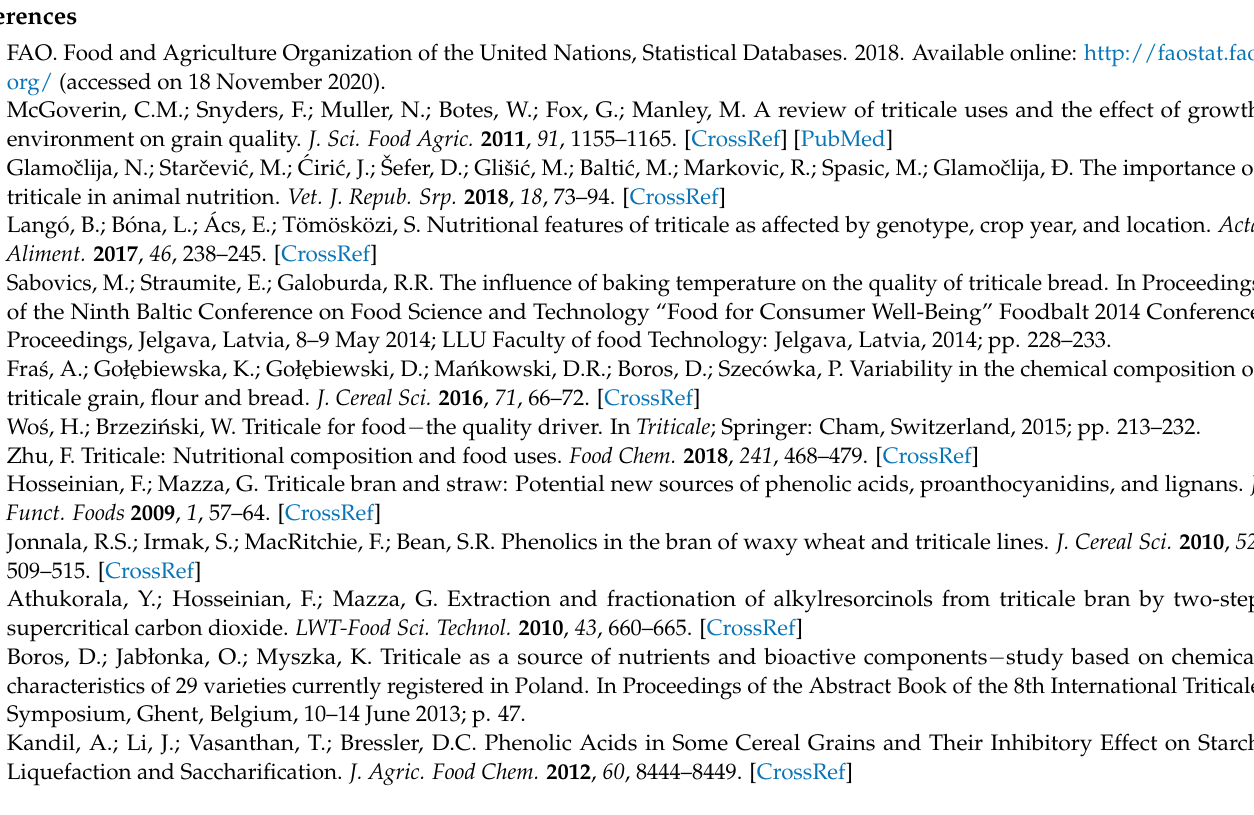
Figure S1: UPLC chromatogram of triticale grain variety Borwo, Figure S2: UPLC chromatogram of triticale grain variety Fredro, Figure S3: UPLC chromatogram of triticale grain variety Pantenon, Figure S4: UPLC chromatogram of triticale flour, Figure S5: UPLC chromatogram of triticale bran, Figure S6: UPLC chromatogram of triticale